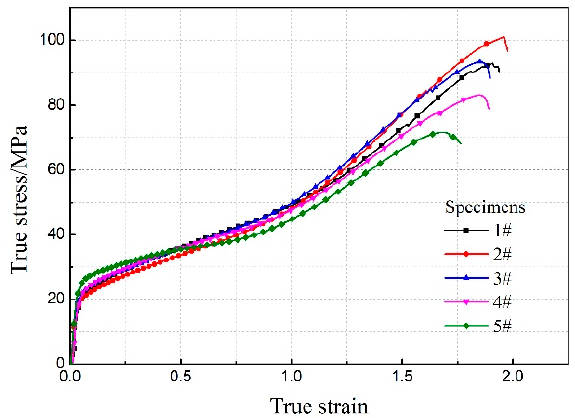
Figure 2. True stress-strain curves of Al / ZrH 2 / PTFE (aluminum-zirconium hydride-polytetrafluoroethylene) specimens in quasi-static compression tests. Table 2. Average mechanical parameters of Al / ZrH 2 / PTFE composites. Elastic Modulus Yield Strength Specimens (MPa)